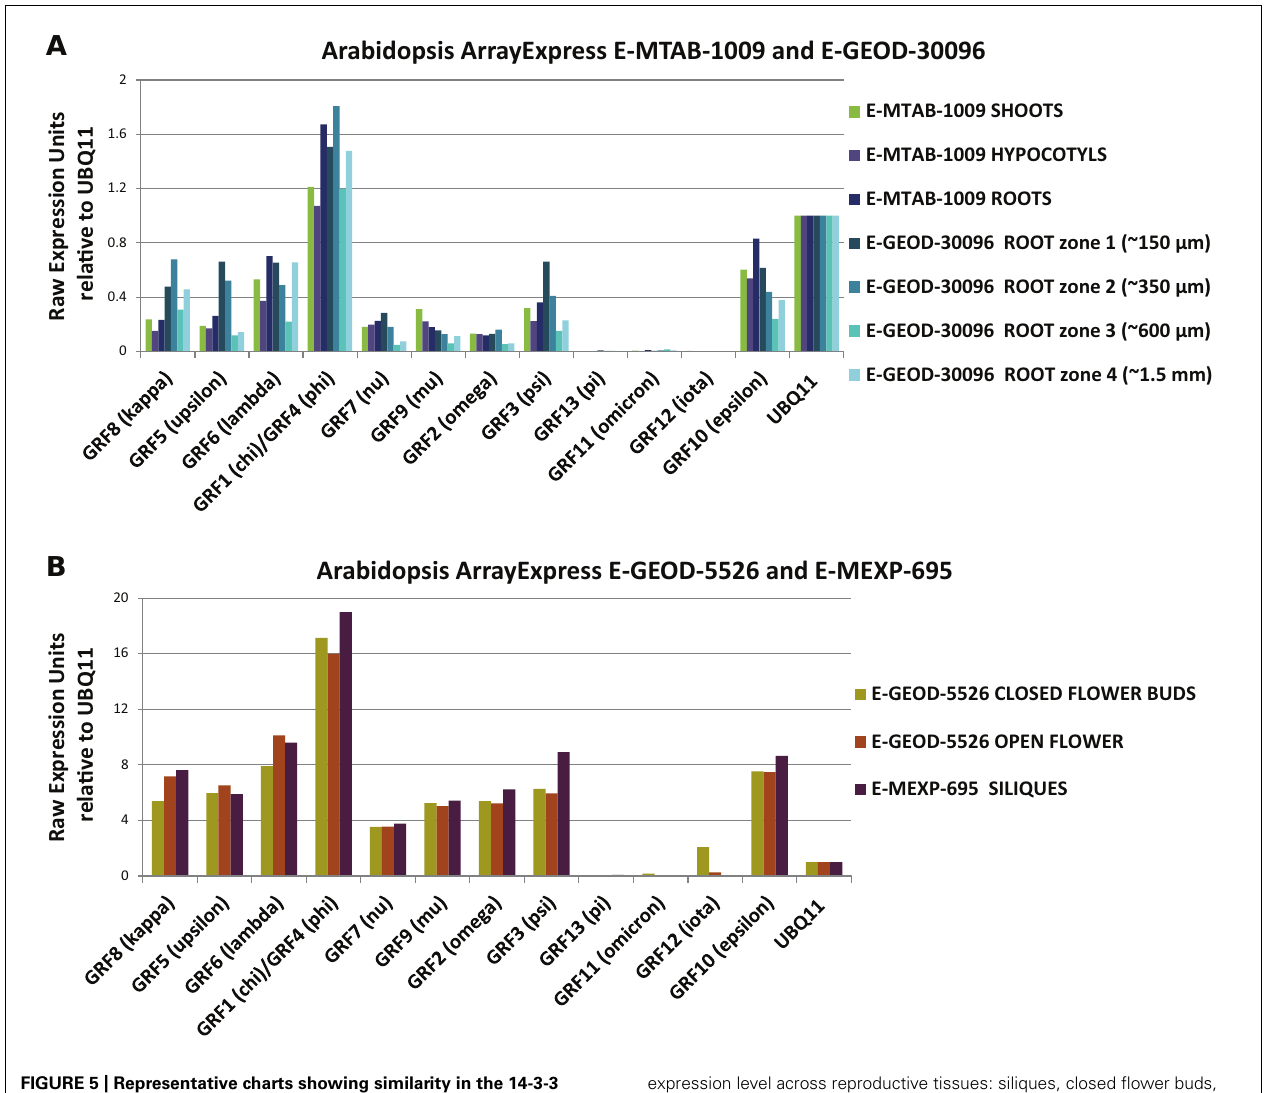
expression level across reproductive tissues: siliques, closed flower buds, and open flowers were included.The asterisk indicates the higher 14-3-3 iota isoform expression level exclusively in closed flower buds (B) . Notes: GRF ( λ )/GRF4 ( ϕ ) label: GRF1 ( λ alias GF14 λ ; At4g09000), and GRF4 ( ϕ alias GF14 ϕ ; At1g35160) share same probe 255079_s_at on A-AFFY-2 - AffymetrixGeneChip Arabidopsis Genome [ATH1-121501]. As other _s_at probes (_s indicating Similarity) this probe represents a set with all probes common among multiple transcripts within a gene family, in this particular case chi and phi therefore both genes GF14 PHI and CHI could be found as annotated for the same probe. All other 14-3-3 members have unique probe IDs on ATH1-121501 arrays (_at individual